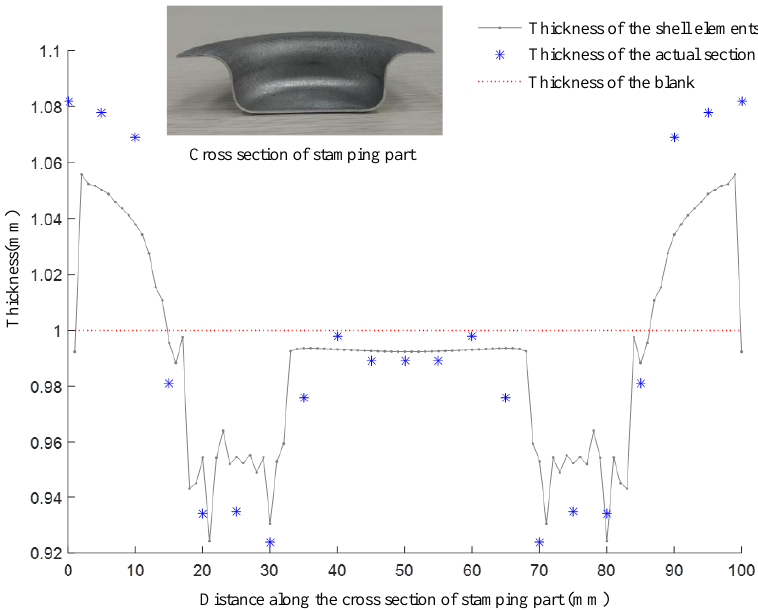
Figure 14. Thickness variation along the symmetrical section of the experimentally obtained parts and simulation result.